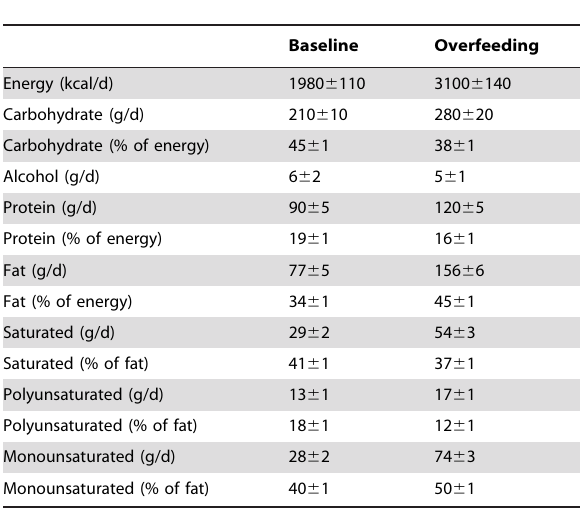
Table 2. Composition of the diet at baseline and during overfeeding.